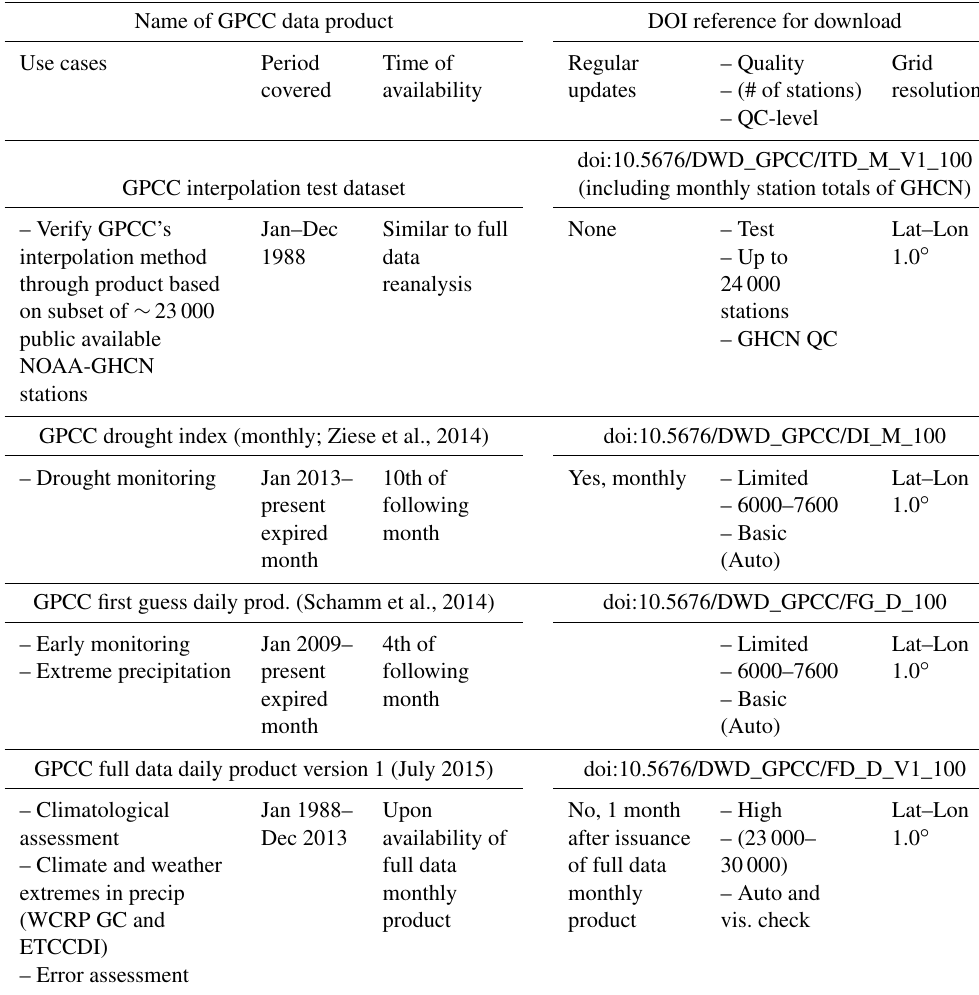
Table 2. New GPCC data products issued in July